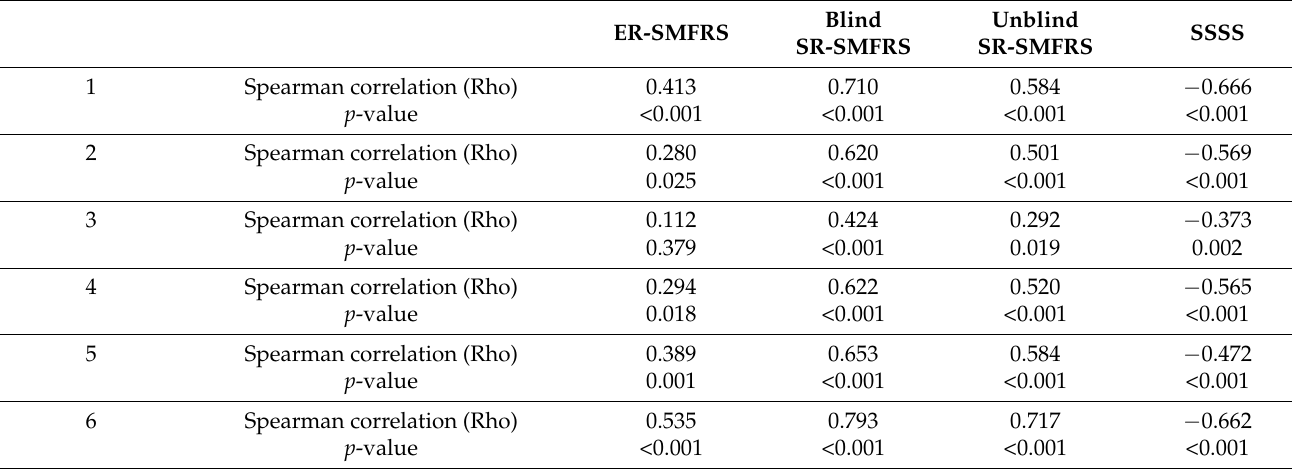
Table 8. Correlation of SR-SMFPIS with DAS24, BIQLI, and cervicomental angle.